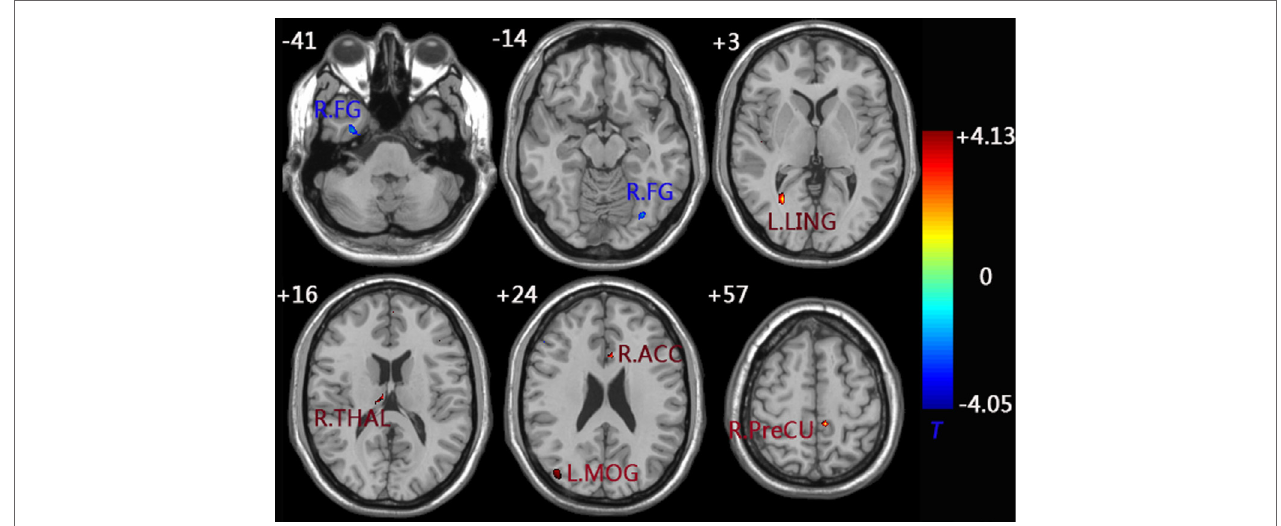
FigUre 3 | functional connectivity difference maps of the left Fg between the aMci and control group; ( P < 0.01, 28 voxels, corrected for multiple comparisons) . Abbreviations: FG, fusiform gyrus; MOG, middle occipital gyrus; LING, lingual gyrus; PreCU, precuneus; ACC, anterior cingulate cortex; THAL, thalamus; L, left; R,